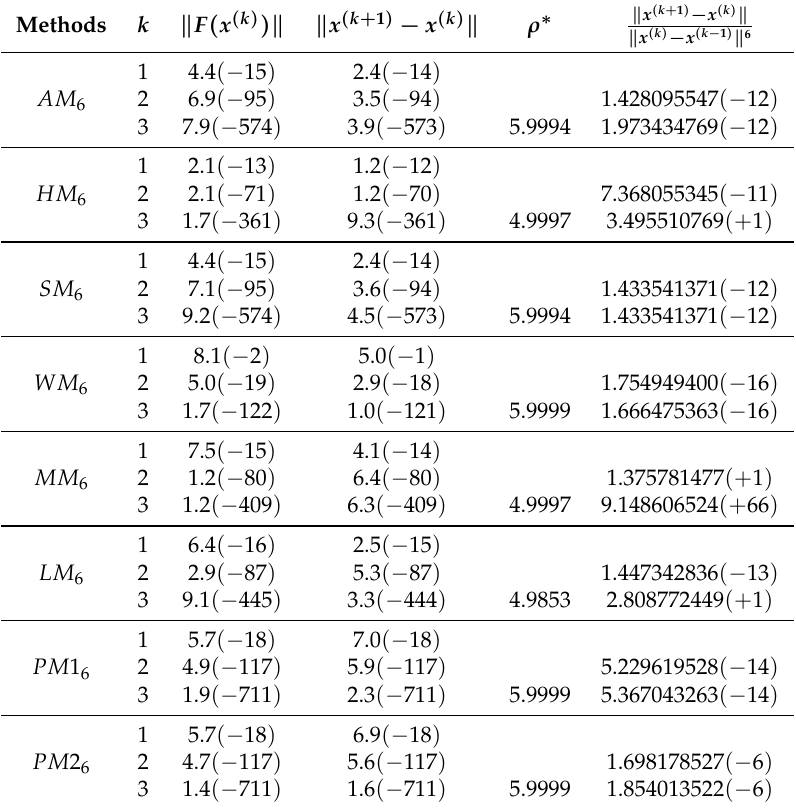
Table 4. Comparisons of different methods on 2D Bratu problem in Example